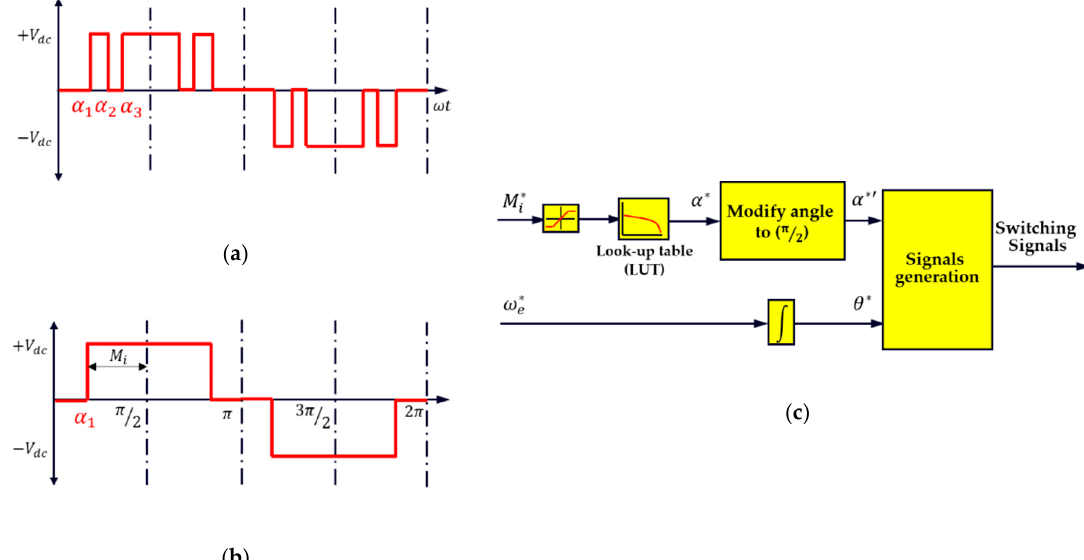
Figure 16. Selective Harmonic Elimination (SHE) for three-level Neutral-Point-Clamped (3L-NPC): ( a ) Phase voltage for the case of three switching angles; ( b ) phase voltage for the case of one switching angle; ( c ) Selective Harmonic Elimination (SHE) block diagram.